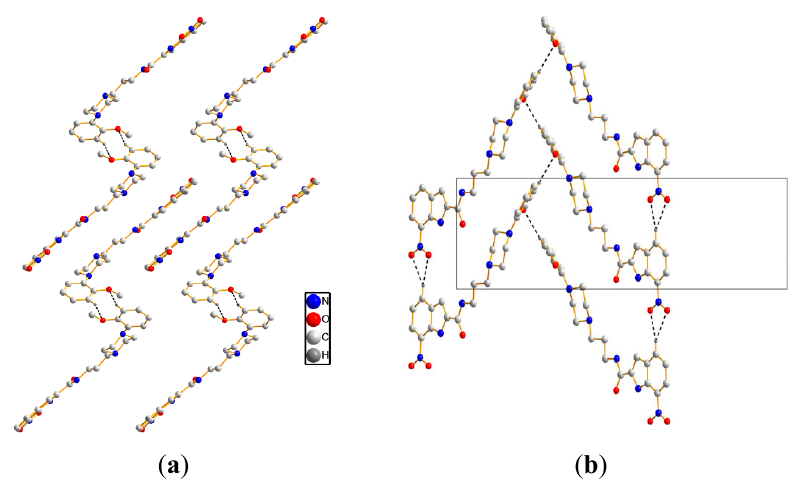
Table 2. Intermolecular hydrogen bonds for compound 1 (Å, °). Figure 3. Crystal packing of 1 . ( a ) viewing along the b axis; ( b ) viewing along the a axis. Black dashed